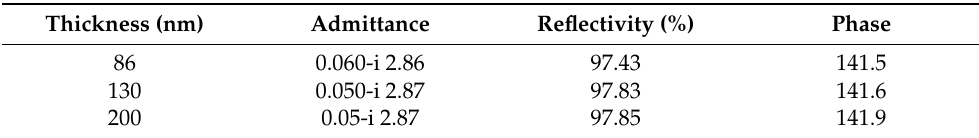
Table 2. The designed optical admittances, reflectivity, and phase of the silver layers with different thicknesses at the 500-nm wavelength.